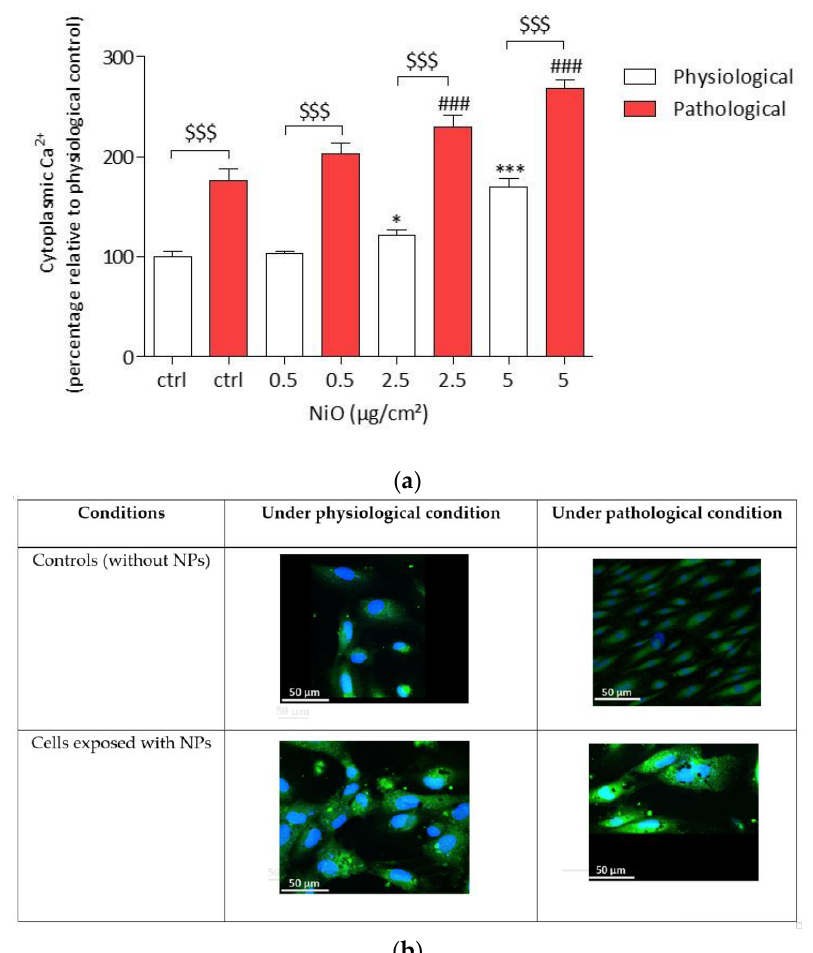
Figure 6. Resting [Ca 2+ ] c in HPAEC cells after a 4 h exposure to NiONPs (0.5–5 μg/cm 2 ) in physio- logical and pathological conditions, measured with Fluo-4 probe (1 µM) by confocal microscopy. ( a ) The values were normalized to the untreated physiological cells and results were expressed as the percentage of the Fluo-4-AM probe fluorescence intensity relative to the physiological controls. ( b ) HPAEC observed by confocal microscopy at focus ×60, under physiological and pathological con- ditions, without or with NiONPs (5 µg/cm 2 ), with cytoplasmic calcium marked in green with Fluo- 4-AM probe and nucleus in blue with Hoechst probe. Data were mean ± SEM of three independents experiments ( n = 3) performed in quadriplicate. * p < 0.05 and *** p < 0.001 vs. untreated cells in 0% CS in normoxic conditions. ### p < 0.001 vs. untreated cells in pathological conditions. $$$ p < 0.001 between both conditions. According to one-way ANOVA followed by Tukey’s post-test for multiple comparisons.